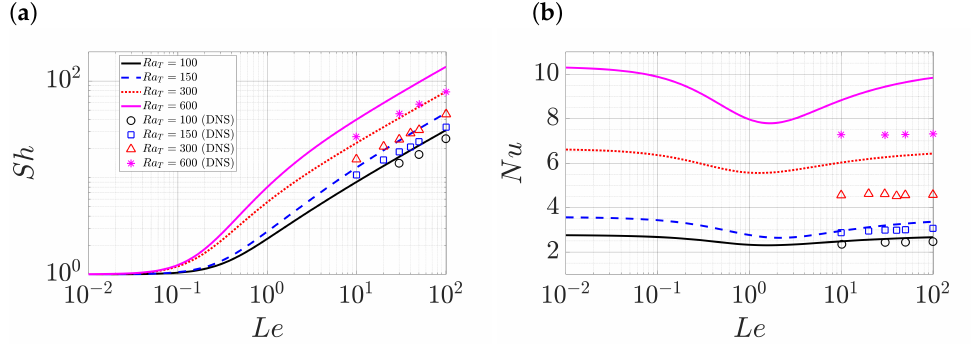
Figure 14. ( a ) Sh and ( b ) Nu , both as a function of Le , from the single-mode equations (lines) at R ρ = 0.2, k y = 0, and Ra T = 100, 150, 300 and 600 and wavenumbers k x = n π / L x ,NBC = π , 2 π , 2 π , 4 π , respectively, compared with the corresponding DNS results (markers) (Figure 4 in